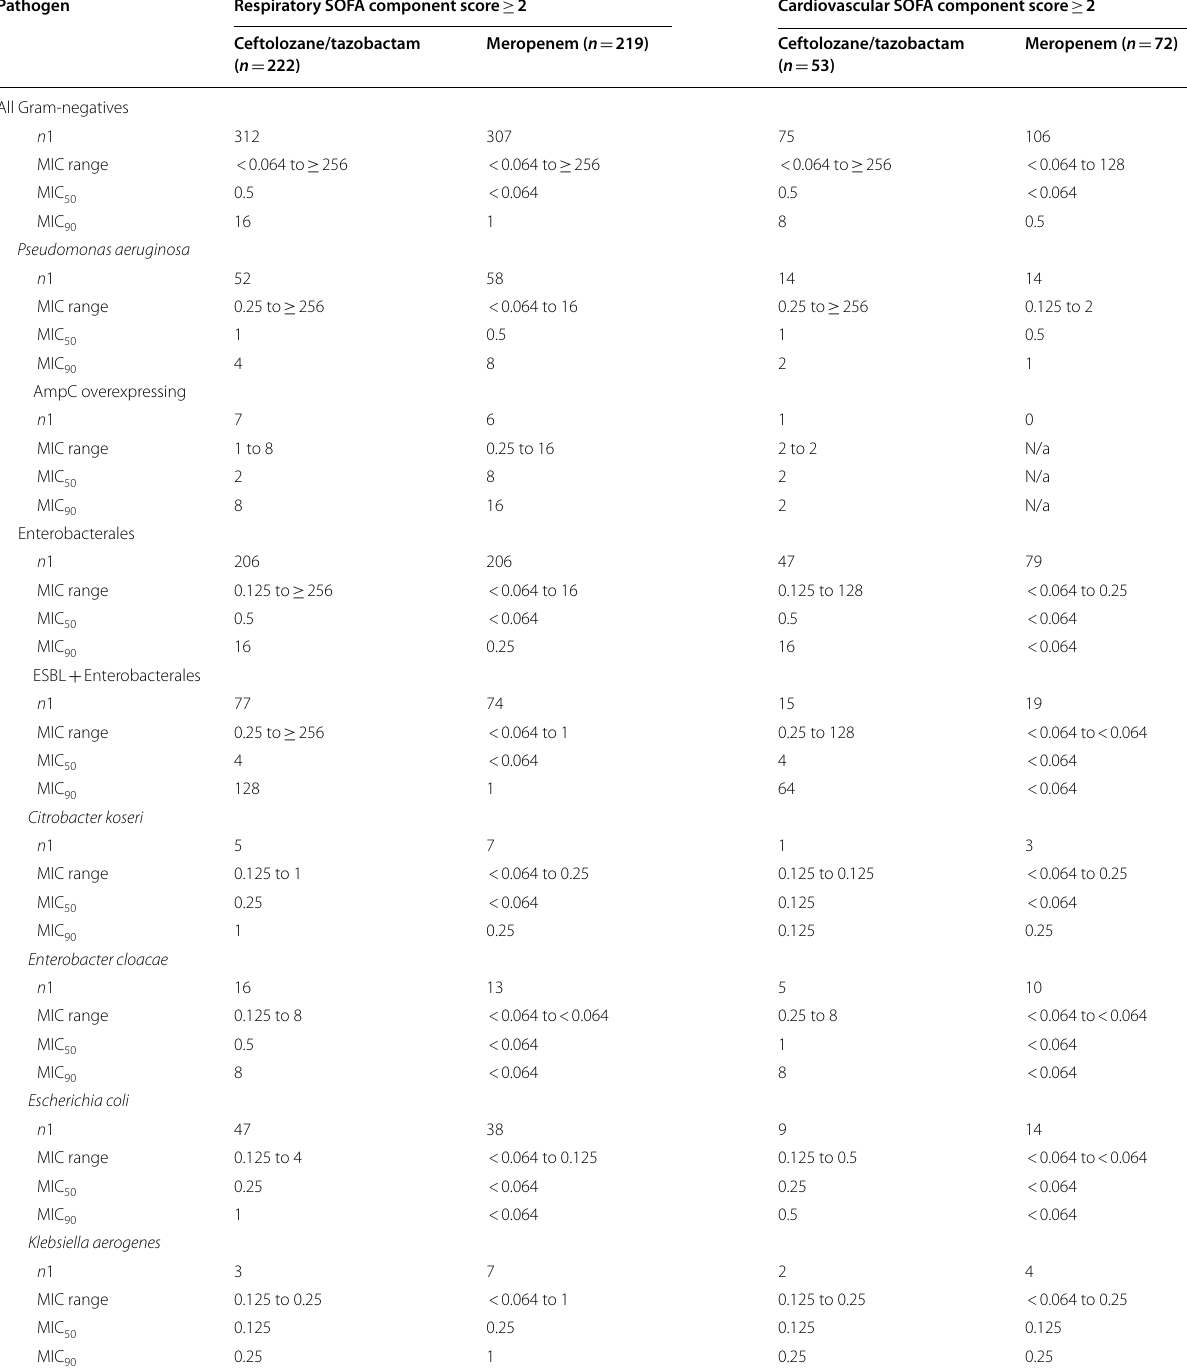
2 or CV‑SOFA 2 (mITT ≥ ≥